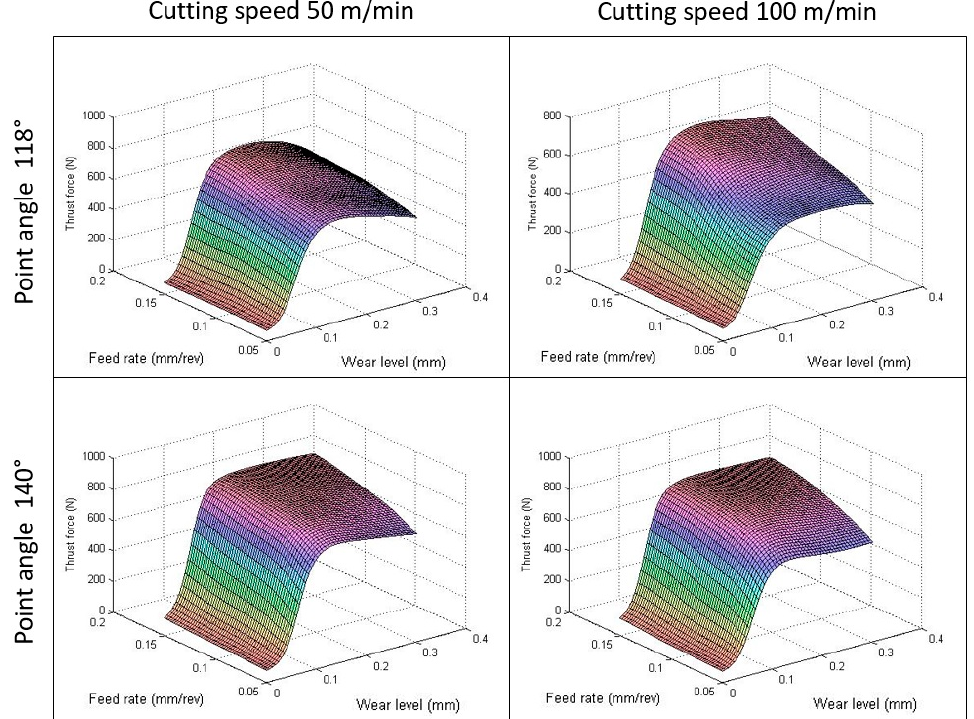
Figure 9. Interaction effects of the feed rate and wear level on the thrust force.